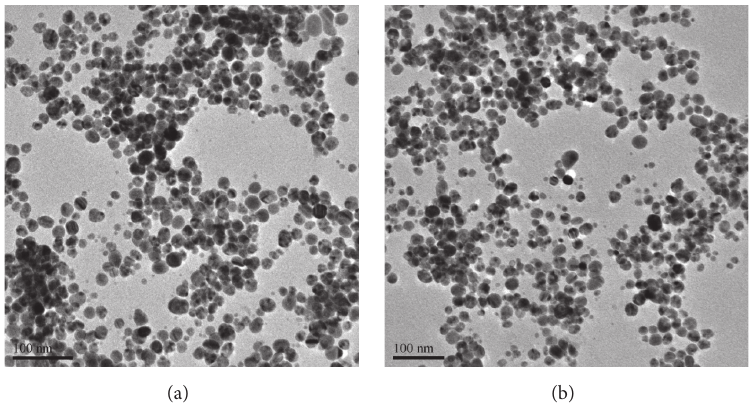
Figure 9: (a) TEM micrograph of WMRE-AgNPs. (b) TEM micrograph of